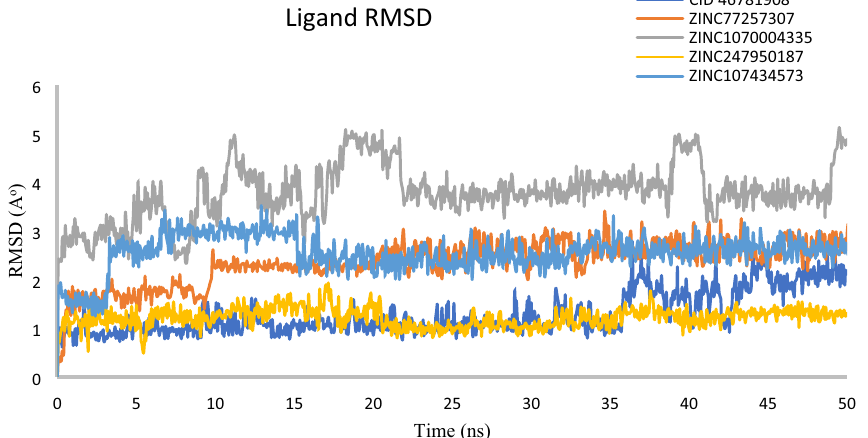
Figure 9. RMSD values extracted from protein fit ligand of the protein–ligand docked complexes, viz CID: 46781908 (Gray), ZINC77257307(orange), ZINC1070004335, ZINC247950187 (Gold), ZINC107434573 (Blue), with respect to 50 ns simulation time.